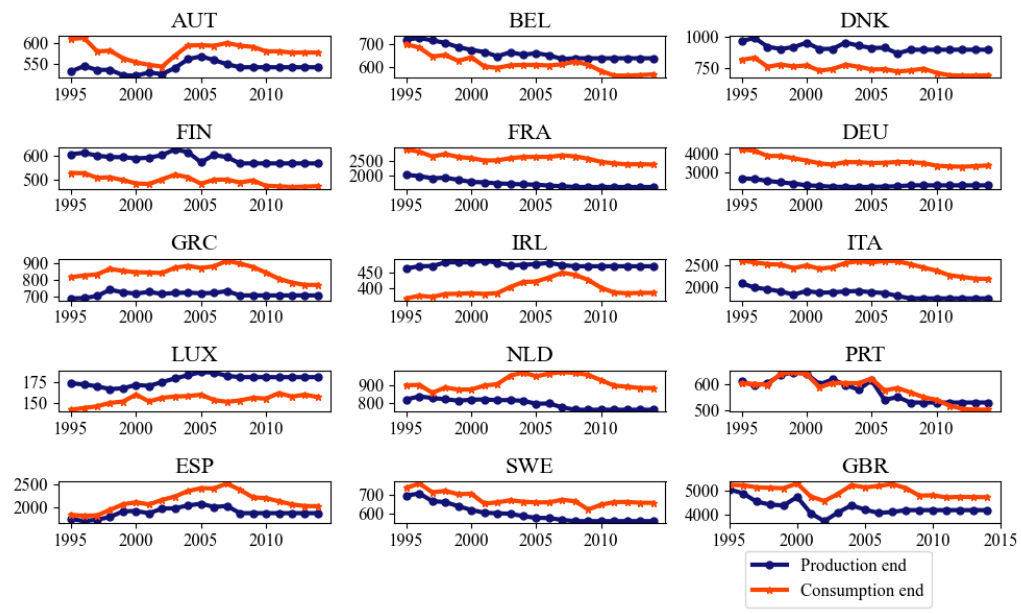
Figure 5. Production and consumption end emissions of 15 EU member countries during the period of 2001–2014 (Unit: